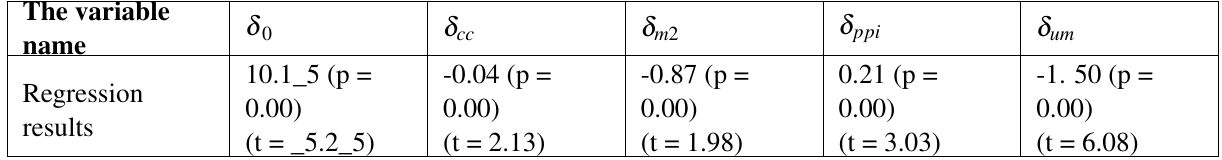
Table 1 Fitting results of state variables to short-term interest rates